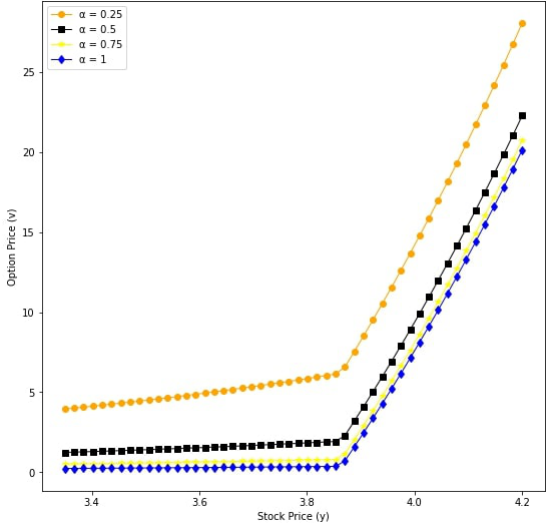
Figure 14. Option prices v ( t , x , y ) with respect to underlying asset y for different α values : v for x = 2.3024 and ρ =